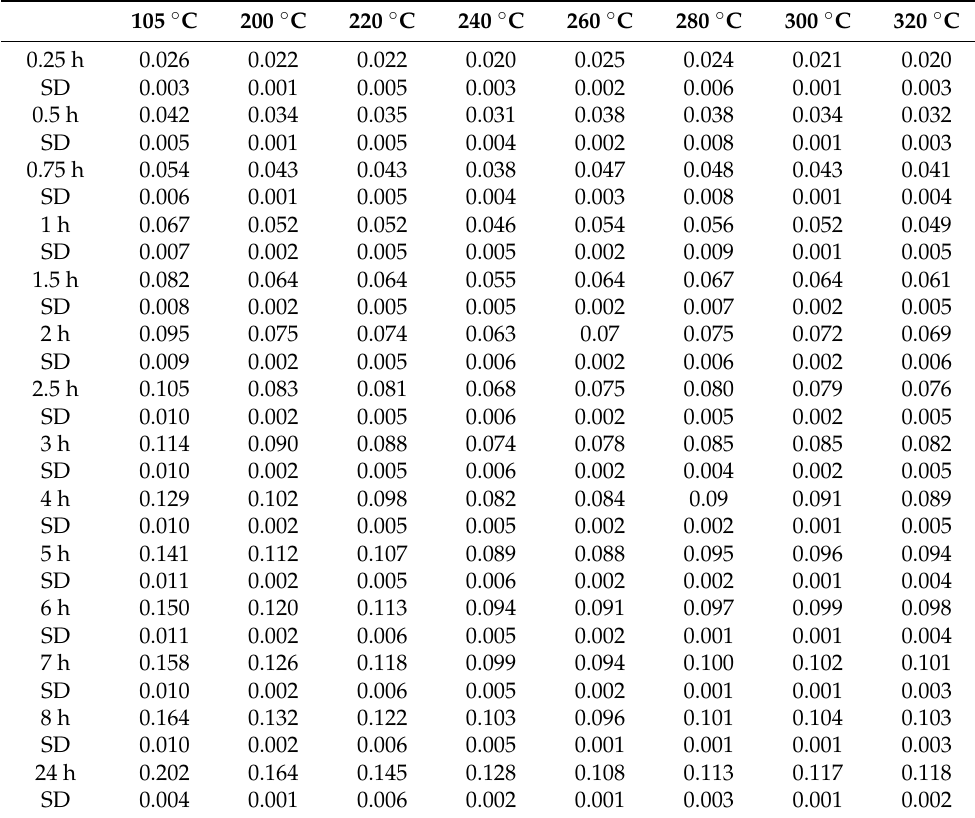
Table 3. Influence of the climatic chamber operation time (CCOT) and the torrefaction temperature on the value of the EMC coefficient for lemon peel.